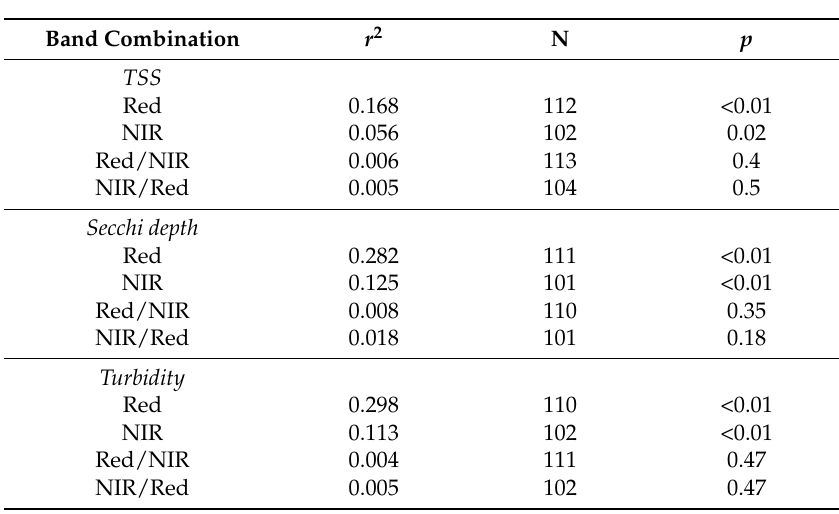
Table 1. Coefficient of determination ( r value), the number of samples/matching pairs (N) and the p value of the correlation of three in situ parameters taken at the surface (Total suspended solid, turbidity and Secchi depth) with Band 1, Band 2, ratio of Band 1: Band 2 and ratio of Band 2:1 reflectance values. TSS is the abbreviation for total suspended solid.